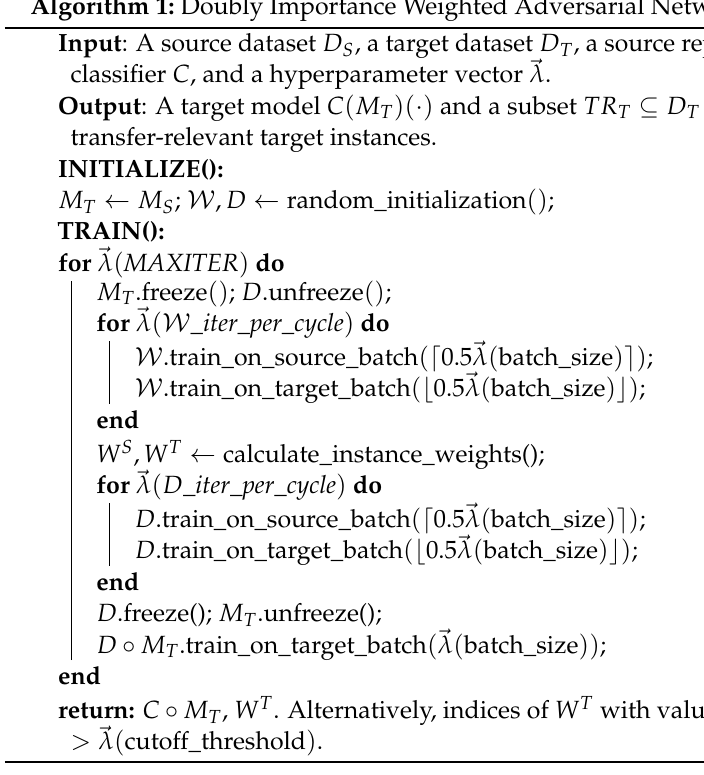
Algorithm 1: Doubly Importance Weighted Adversarial Network